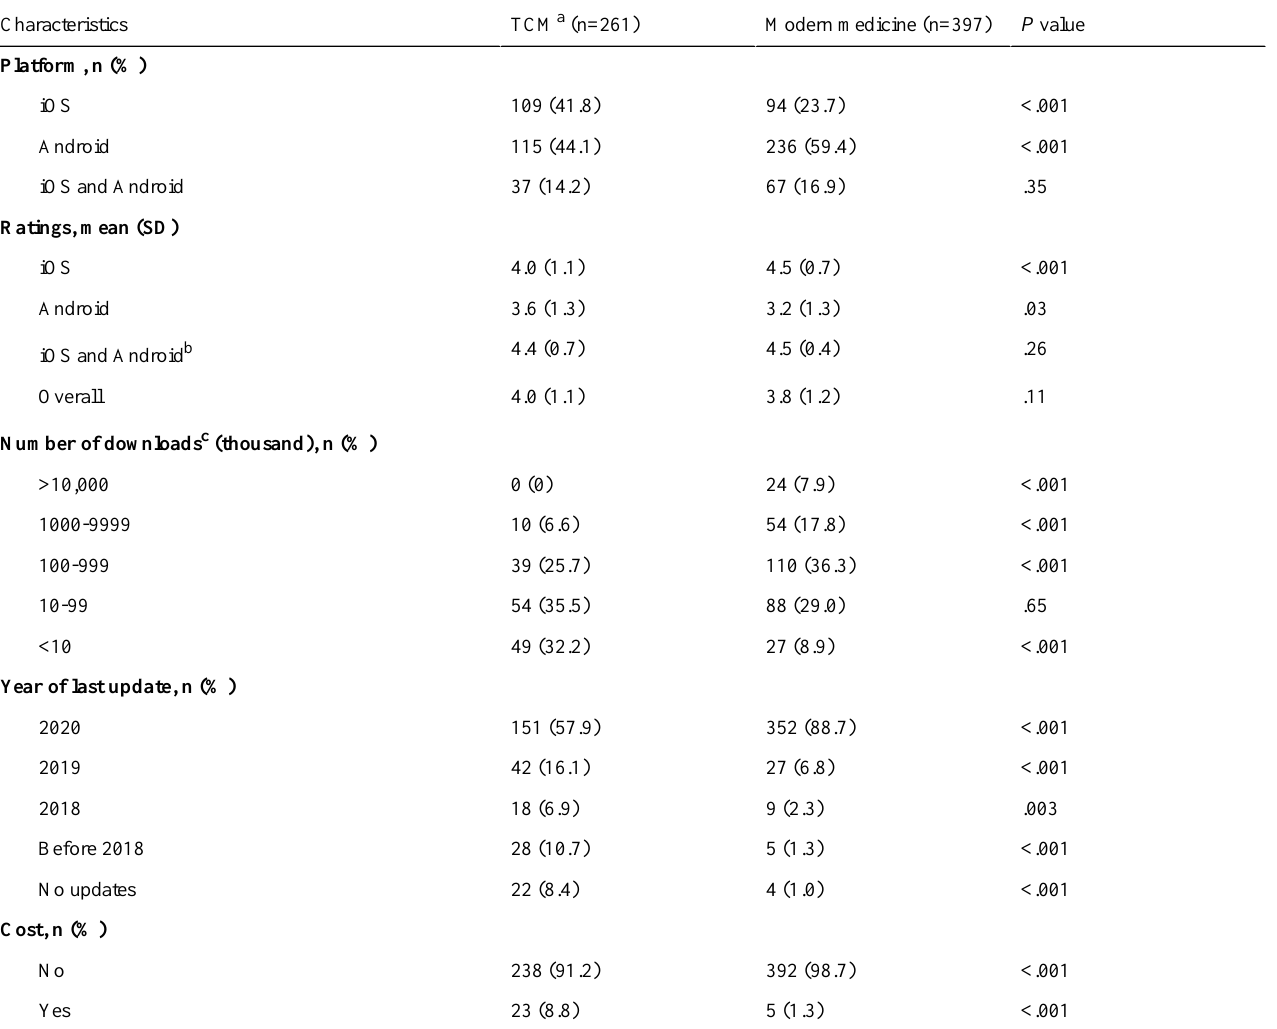
Table 1. General characteristics of TCM apps and modern medicine